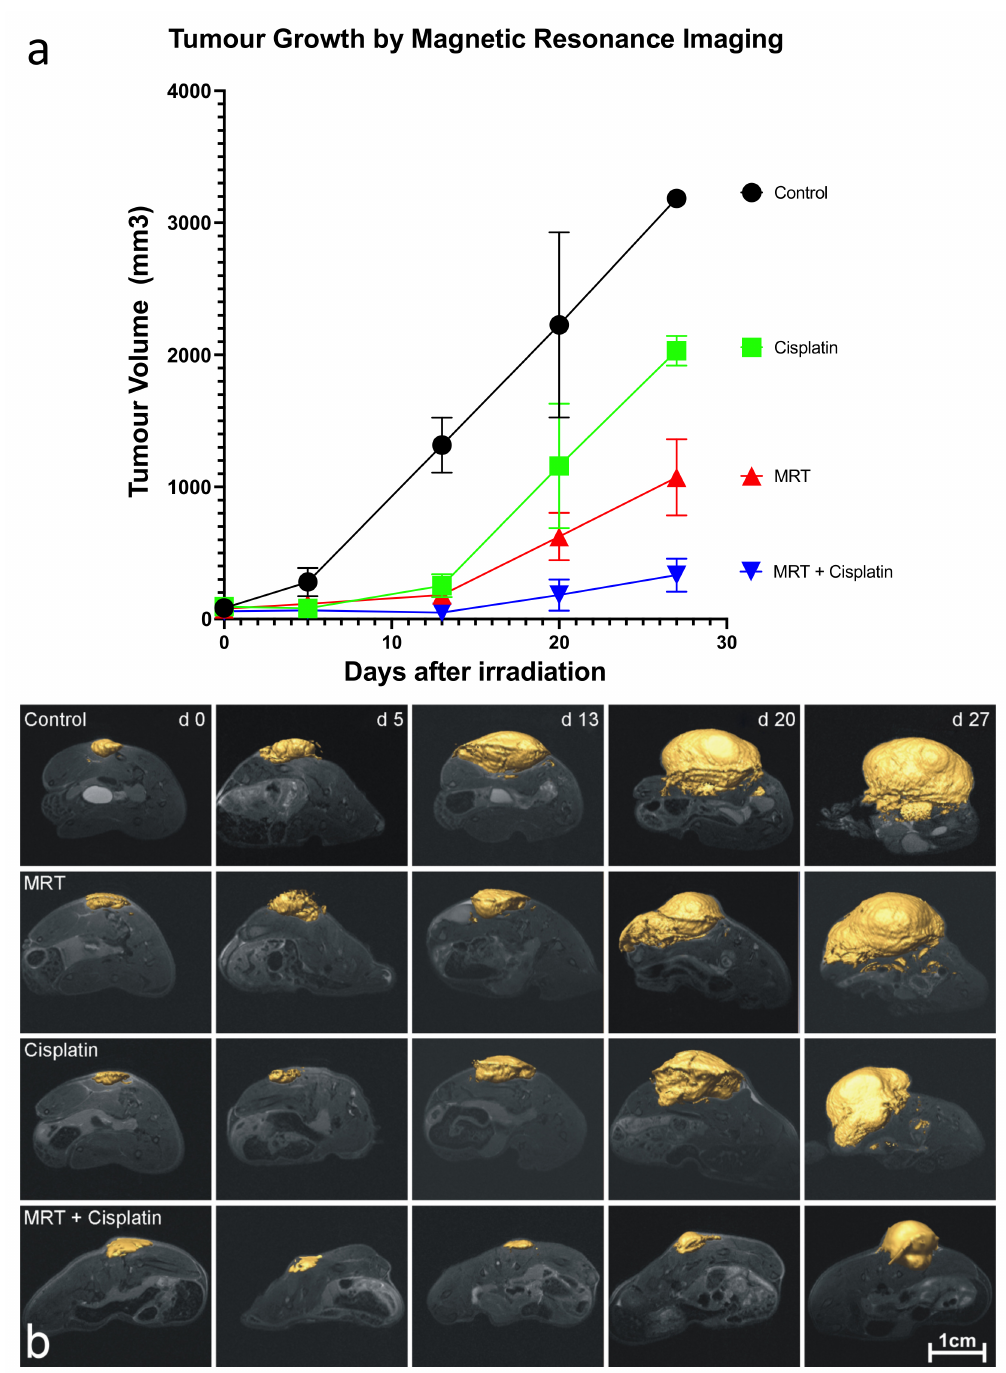
Figure 5. U-87 glioblastoma growth followed by MRI. Image ( a ) shows the tumor volume growth measured by MRI. Image ( b ): MRI images of the tumor progression for each animal group. Control ( n = 3), Cisplatin ( n = 4), 150 Gy MRT ( n = 7), and Double Treatment (150 Gy MRT + Cis) ( n =